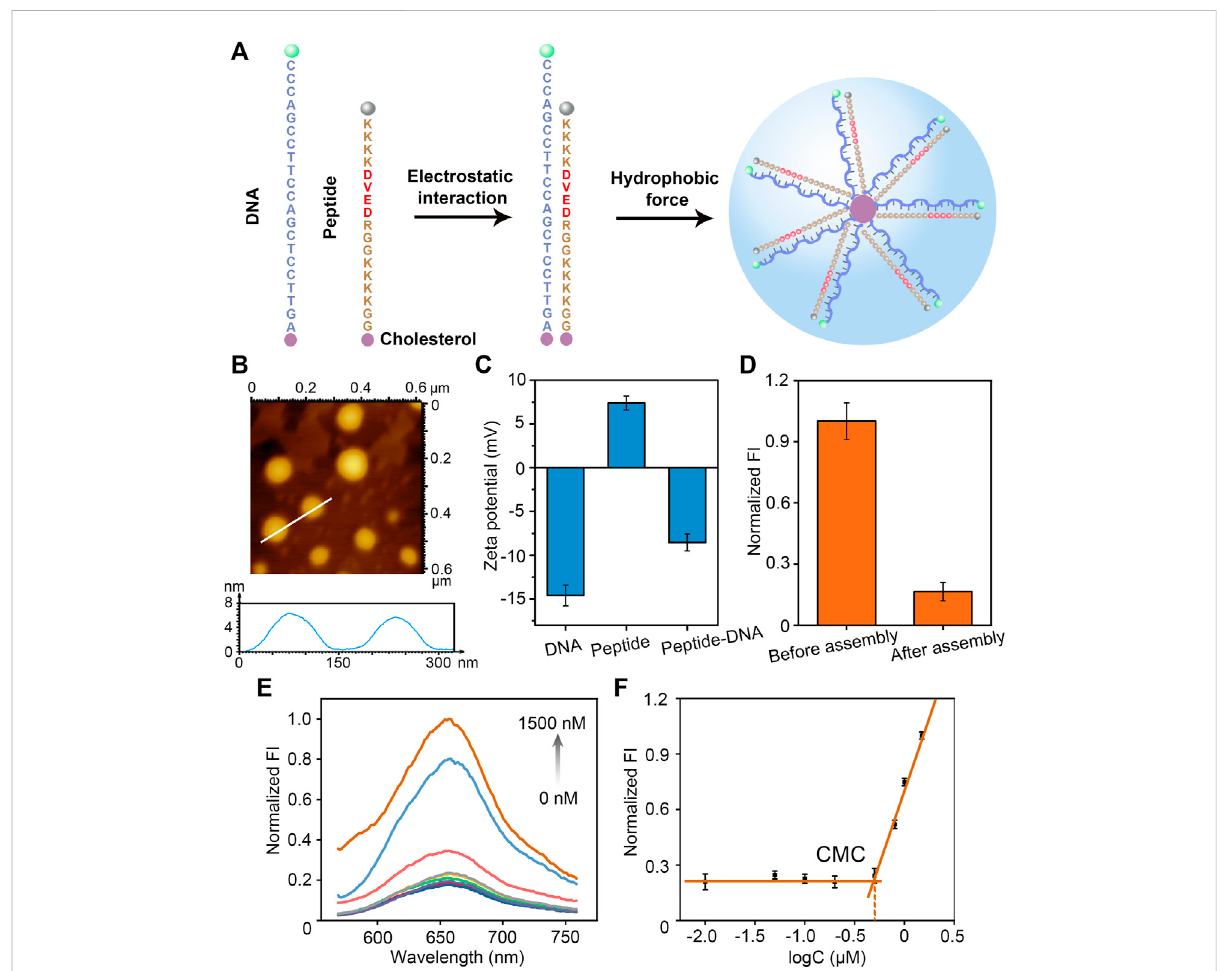
FIGURE 1 Design, construction and characterization of peptide-DNA hybrid bio-nanomicelles. (A) Sequence design and formation principle of peptide- DNA hybrid bio-nanomicelles (Caspase-3 speci fi c recognition cleavage sites in red) (B) AFM characterization of peptide-DNA hybrid bio- nanomicelles (C) ζ -Potentialcharacterizationofpeptide-DNAhybridbio-nanomicellesbeforeandafterassembly. (D) Fluorescencecharacterization of peptide-DNA hybrid bio-nanomicelles before and after assembly. Excitation and emission wavelength of FAM is 492 and 522 nm. (E) and (F) Nile red encapsulation method to determine the CMC of peptide-DNA hybrid bio-nanomicelles. Excitation and emission wavelength of Nile red is 535 and 655